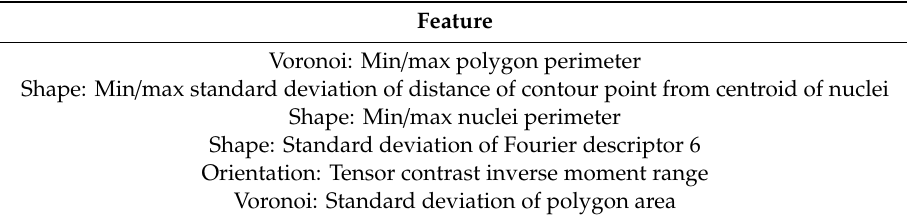
Table 2. The six features identified from D 1 and used in the final model.